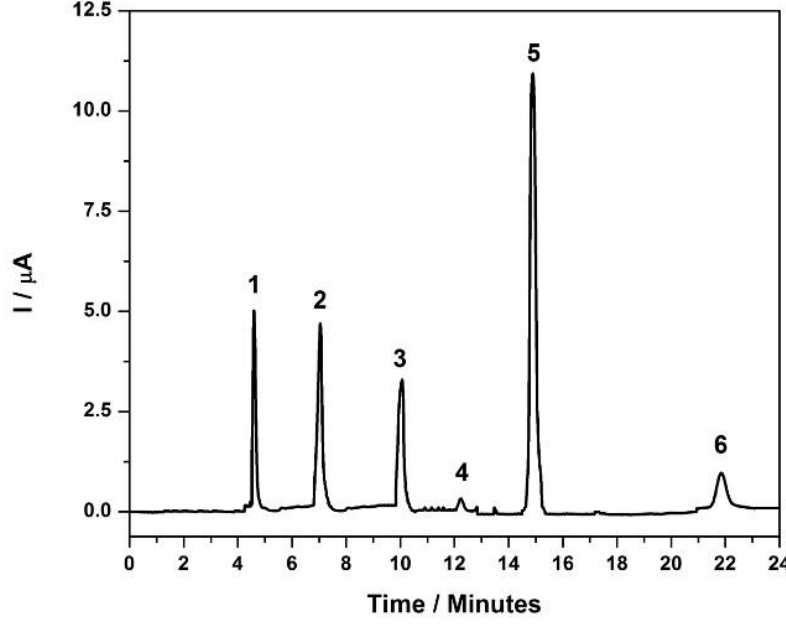
] 70:30 (v/v) T: 40 2